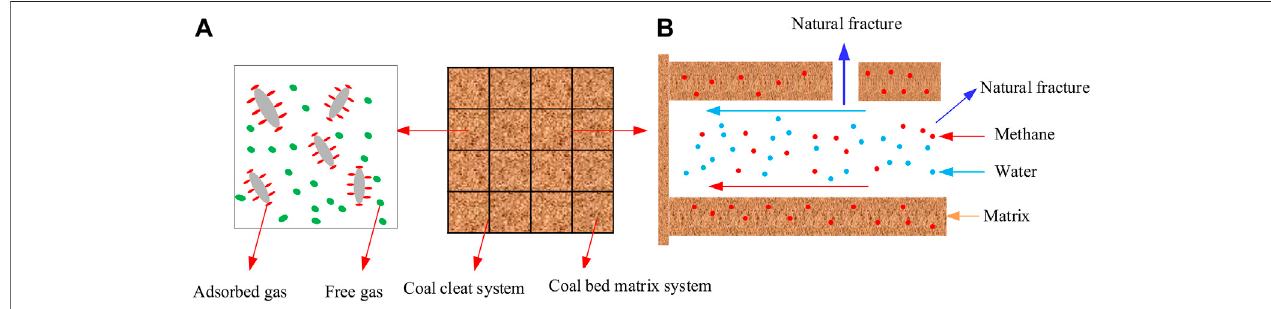
FIGURE1|(A) SchematicdiagramofoccurrencestateofCBM (B) Schematicdiagramofthephysicalmodelofgas-watertwo-phase fl